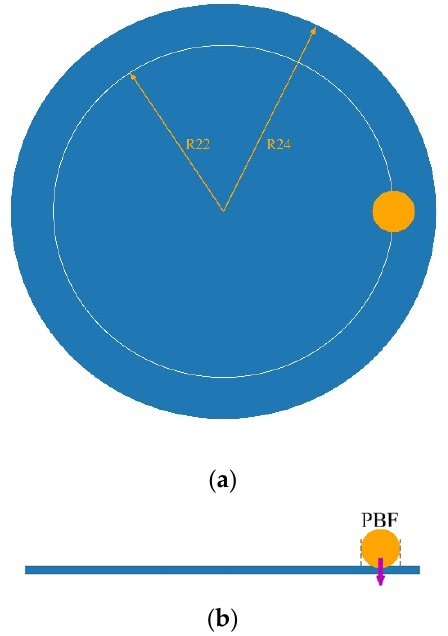
Figure 5. Pin-on-disc setup. ( a ) Top view and ( b ) side view. Table 2. Parameters for DEM simulations